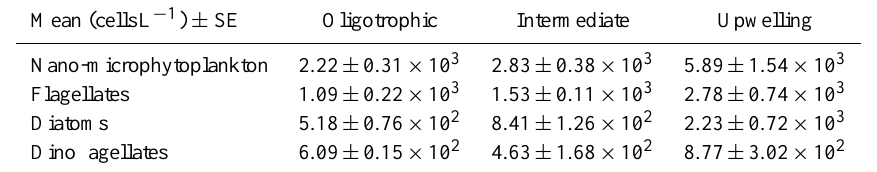
Table 2. Average ± SE of the nano-/microphytoplankton abundances in the three zones.